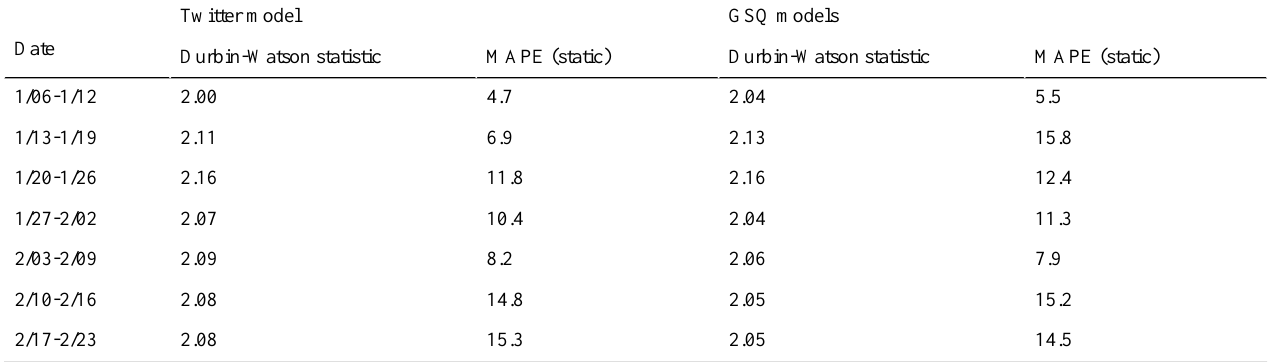
Table 6. MAPE a scores for Infection tweet and GSQ b models for ILI c